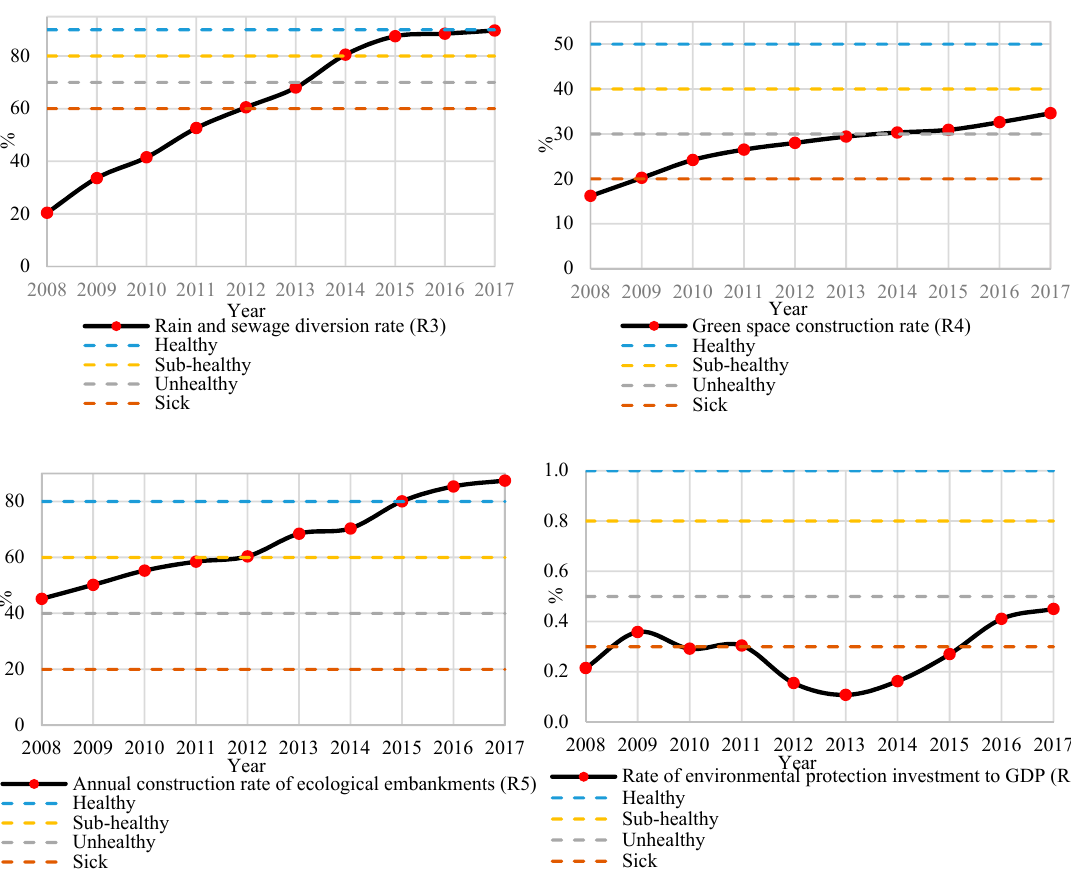
Figure 9. Trends of the main indicators in the response sub-system from 2008 to 2017.